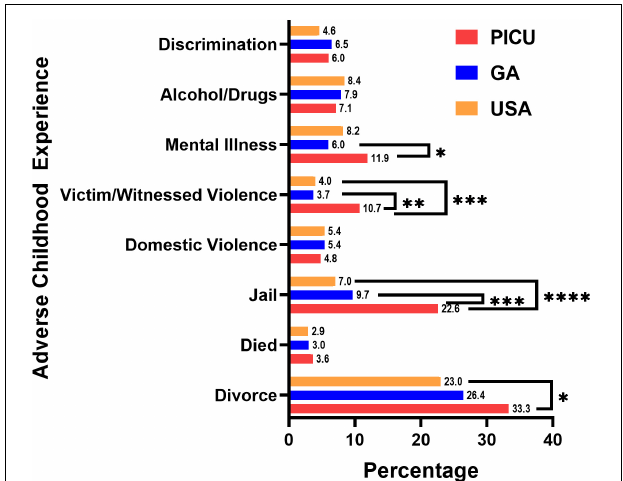
FIGURE 2 | Adverse childhood experiences by type. Children admitted to the pediatric intensive care unit (PICU) had a higher percentage of divorced or separated parents, had a parent who served time in jail, witnessed or was a victim of neighborhood violence, and has lived with a person with mentally illness. Children admitted to the PICU (red bars, n = 84); weighted responses of children living in Georgia from the National Survey of Children’s Health (blue bars, n = 1,889); weighted responses of children throughout the United States (USA) from the National Survey of Children’s Health (orange bars, n = 97,173). Numbers at the top of the bars are the percentage of children experiencing that adverse childhood experience. Only complete cases were included in the analysis. Rao-Scott Chi-square tests were used to compare differences between groups. ∗ p < 0.05, ∗∗ p < 0.01, ∗∗∗ p < 0.001, ∗∗∗∗ p < 0.0001.